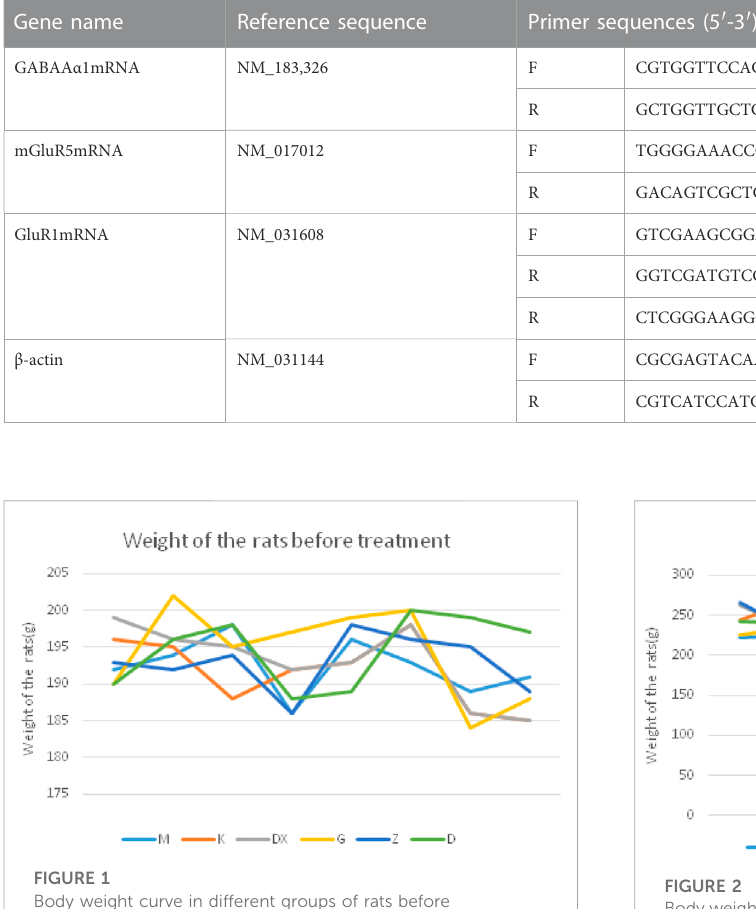
FIGURE 1 Body weight curve in different groups of rats before treatment.